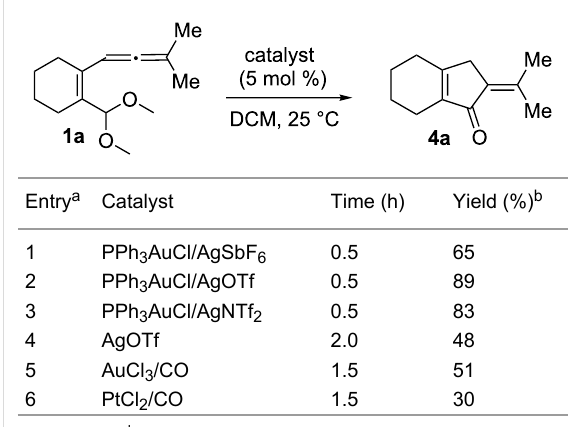
Table 1: Catalyst screening over various acid catalysts.